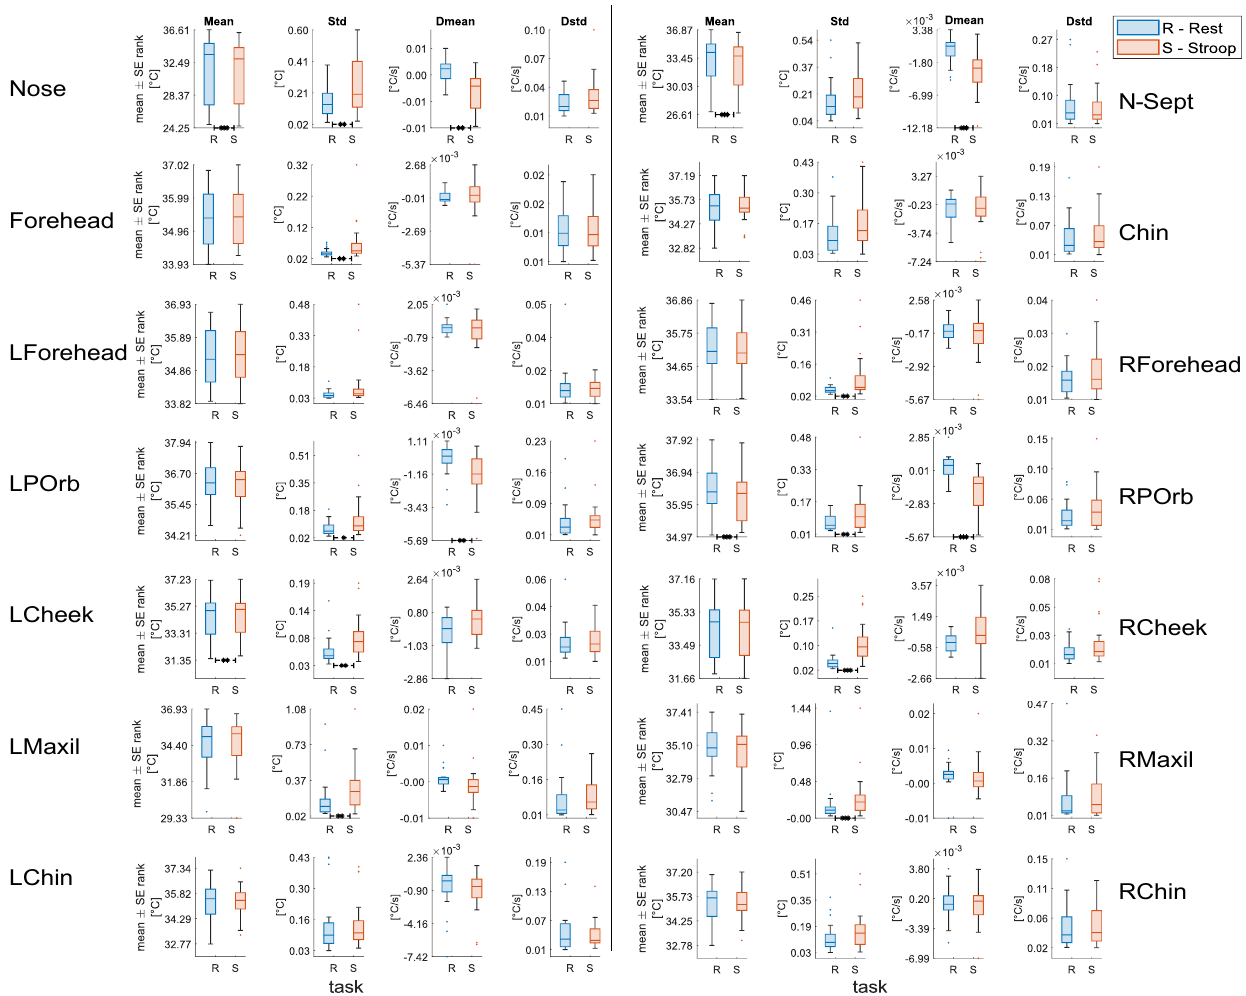
Figure 7. Statistical comparison for the respiratory feature extracted. Significant differences between Rest and Stroop sessions after the Wilcoxon signed rank test with FDR-BH correction are highlighted with an asterisk (* = p < 0.05; ** = p < 0.01; *** = p < 0.001).